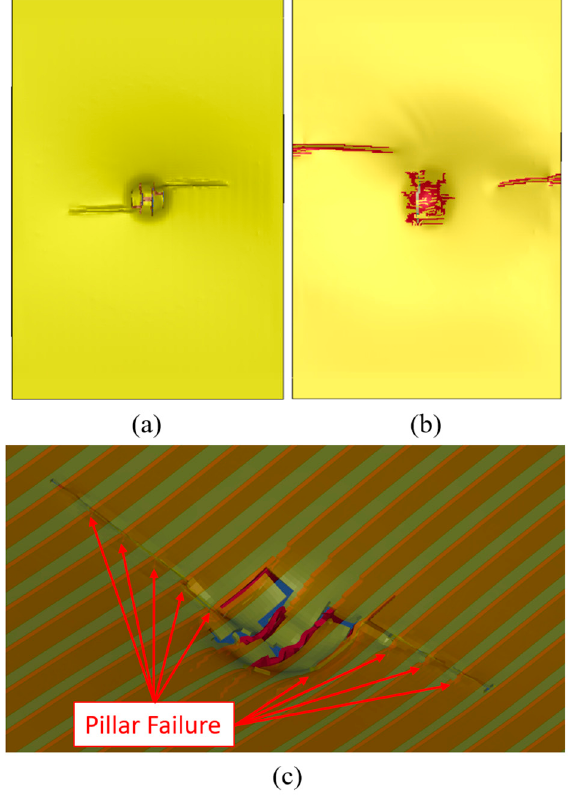
Figure 17. Numerical predictions of the internal failure: ( a ) buckling and cracking on the impacted side of 3DFML skin; ( b ) failure of transverse FRP layer of GLARE on the impacted side; ( c ) failed 3DFGF pillar hidden under buckled skin.